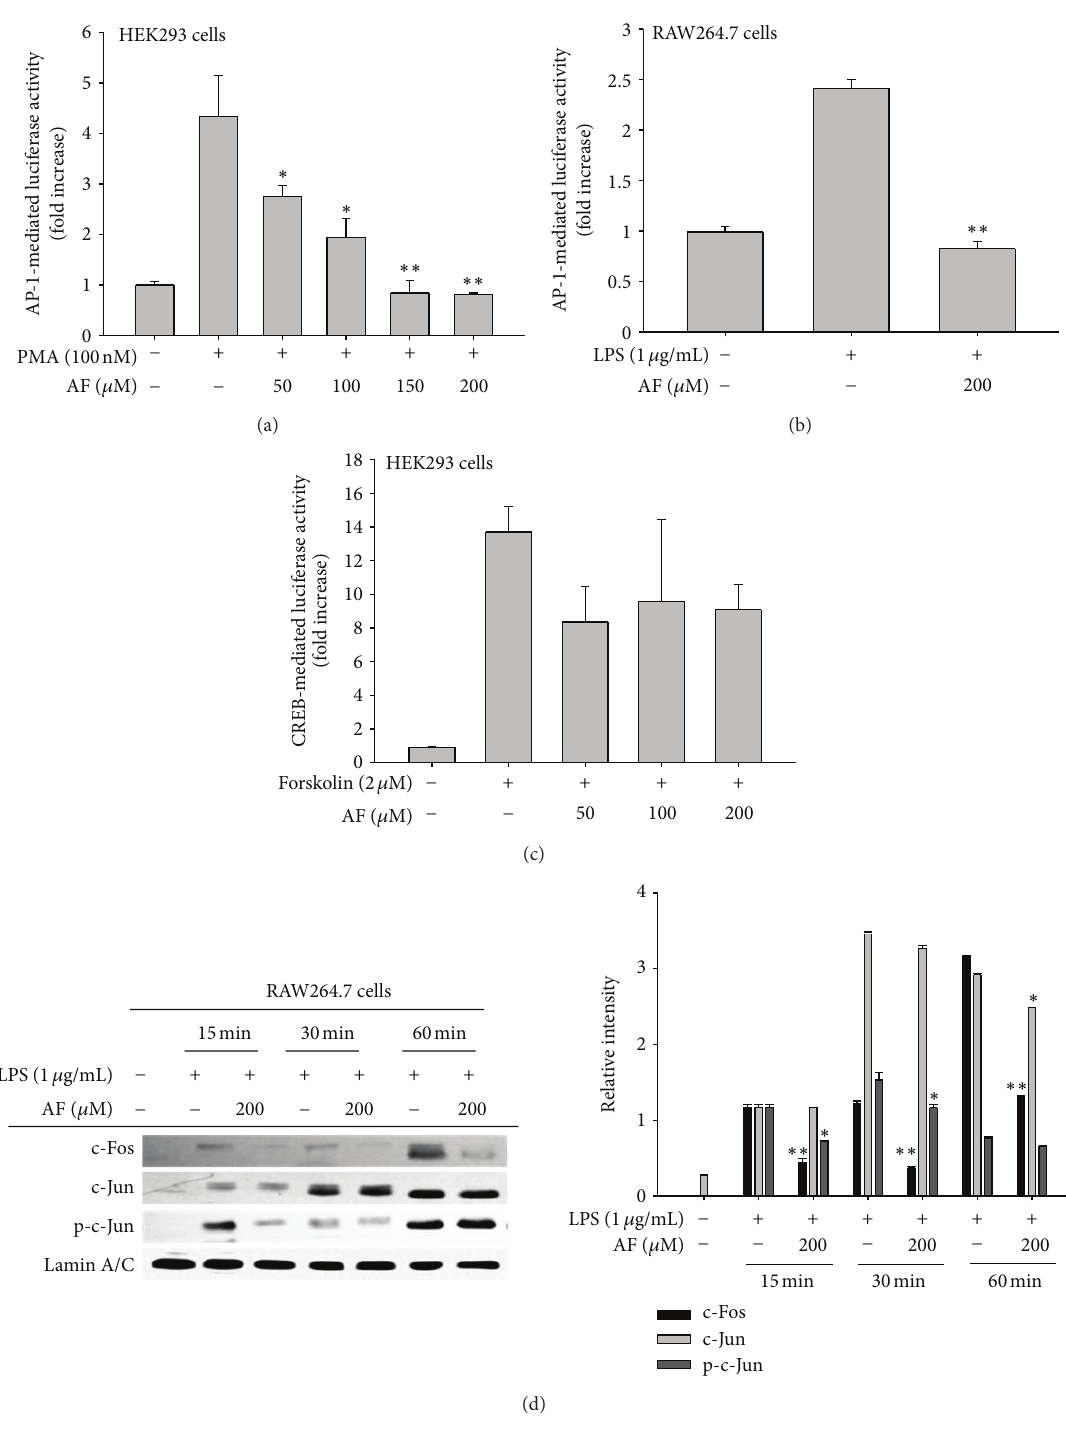
Figure 3: Effect of amentoflavone on transcriptional control of inflammatory genes. (a, b, and c) HEK293 or RAW264.7 cells cotransfected with an AP-1-Luc or CREB-Luc plasmid construct (1 𝜇 g/mL each) and 𝛽 -gal (as a transfection control) were treated with amentoflavone (from 0 to 200 𝜇 M) in the presence or absence of TNF- 𝛼 (15ng/mL), PMA (100nM), forskolin (2 𝜇 M or LPS (1 𝜇 g/mL). Luciferase activity was measured using a luminometer. ((d), left panel) Total and phosphorylated levels of the AP-1 family proteins c-Jun and c-Fos in the nuclear fractions of LPS-treated RAW264.7 cells were determined by immunoblotting analyses using specific antibodies. Relative intensity (left panel) was calculated by the DNR Bio-Imaging system (a GelQuant software Ver. 2.7). RI: relative intensity. ∗ 𝑃 < 0.05 and ∗∗ 𝑃 < 0.01 compared to the